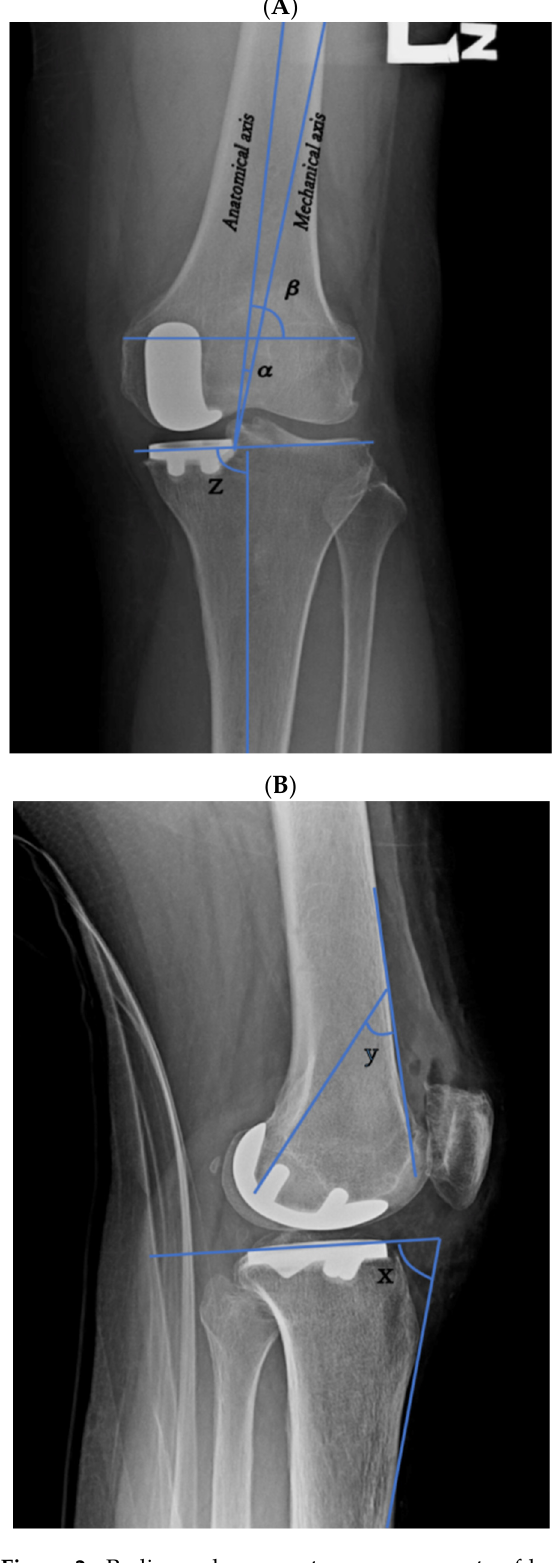
Figure 2. Radiograph parameter measurements of bone alignment and component positioning. ( A ) Anteroposterior view of the left knee indicating the measurement of anatomical axis angle α , femoral condyle angle β , and tibial axis angle z. ( B ) Lateral radiograph of the left knee indicating the measurement of femoral component angle y and tibial slope (90°— x ).